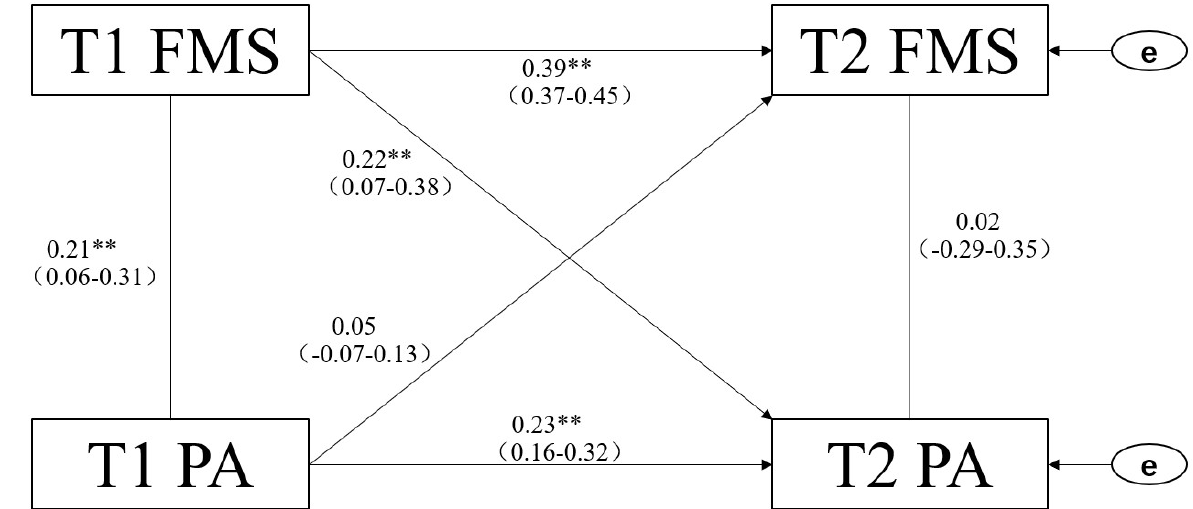
Figure 1. Cross-lag model of PA and FMS. ** denotes a statistically significant path coefficient p < 0.01.